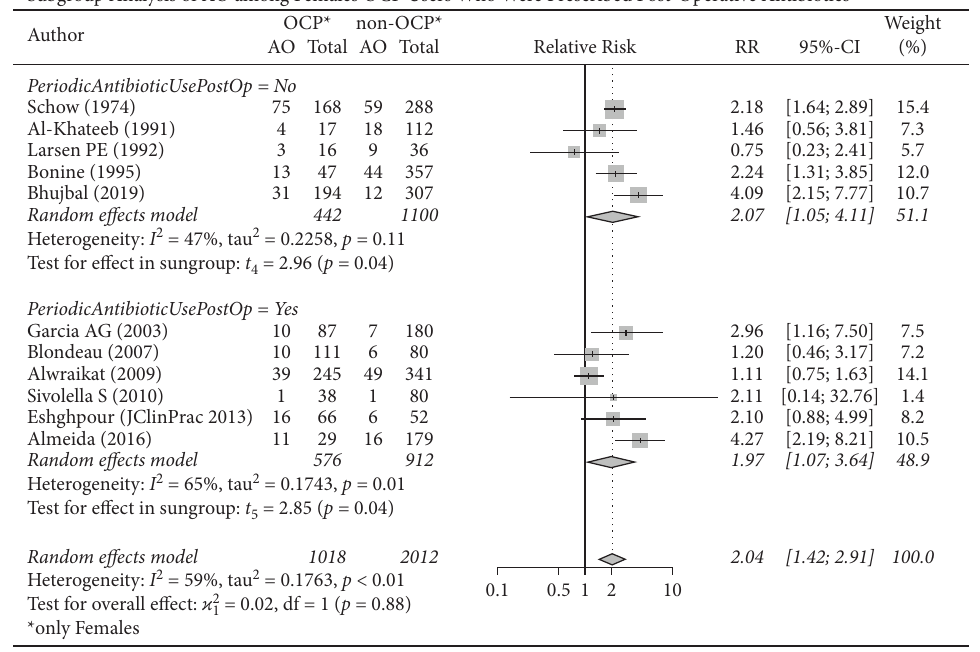
Figure 4: AO and OCPs by analgesics and antibiotics